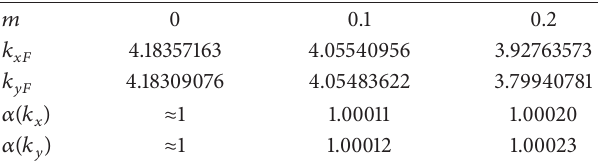
Table 4: Fermi momentums and dispersion relation exponents with different masses for 𝑞 = 2 and 𝑎 2 = 0.01